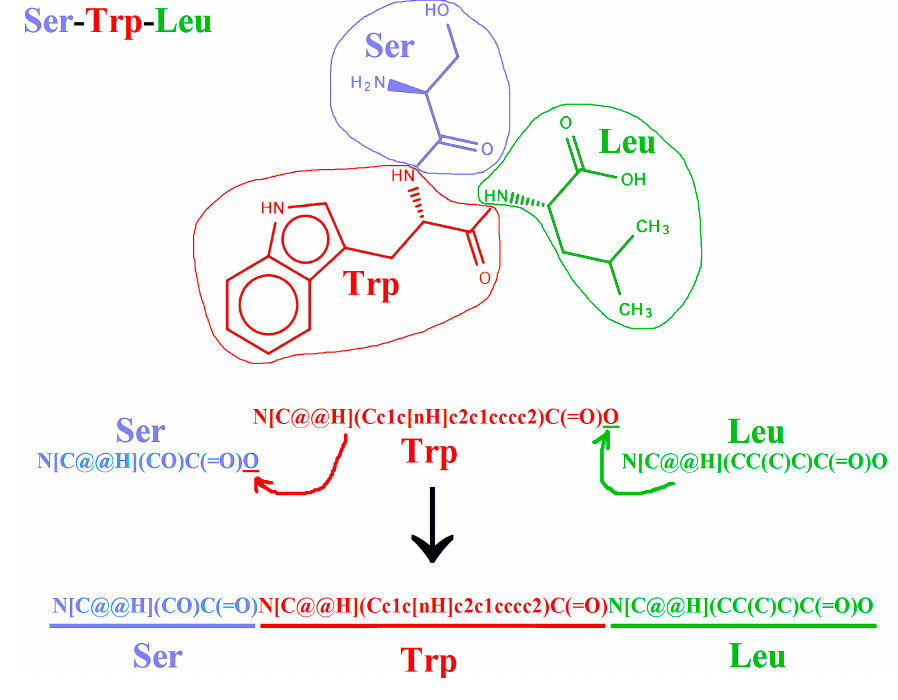
Figure 2. Scheme illustrating manual construction of SMILES representation of peptide SWL (Ser-Trp-Leu): Underlined oxygen atom in SMILES strings of individual amino acid molecues is replaced by the next amino acid residues during construction of peptide representation. Picture of peptide structure prepared with the help of Ketcher 2.0 molecular editor (Demo version).